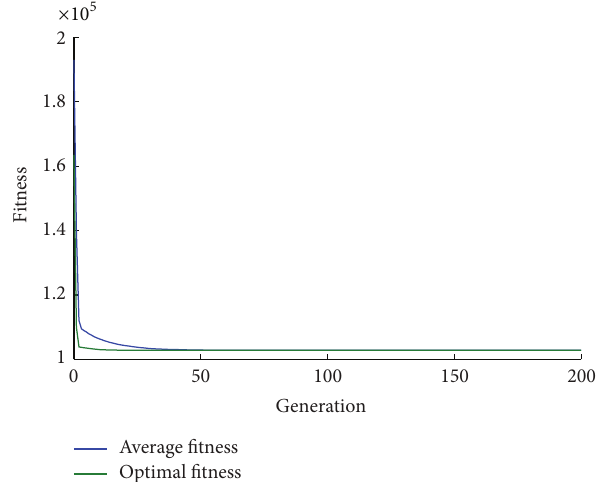
Figure 8: Average fitness and optimal fitness of the population changing with iteration times.